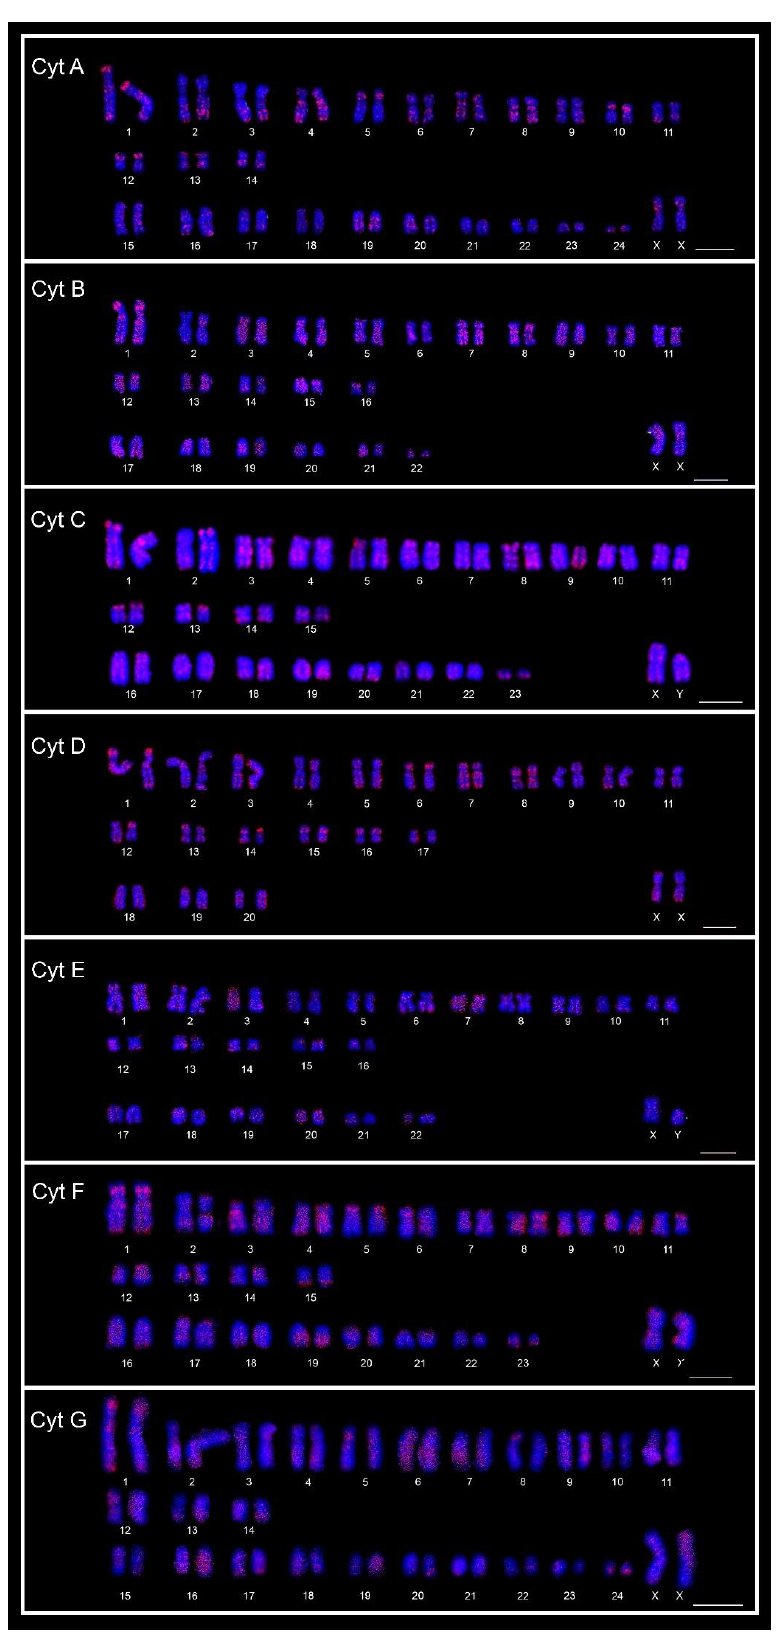
Figure 3. FISH karyotypes of the seven cytotypes (Cyt A–G) of Ctenomys minutus with the A 30 motif probe. Bar = 10 µ